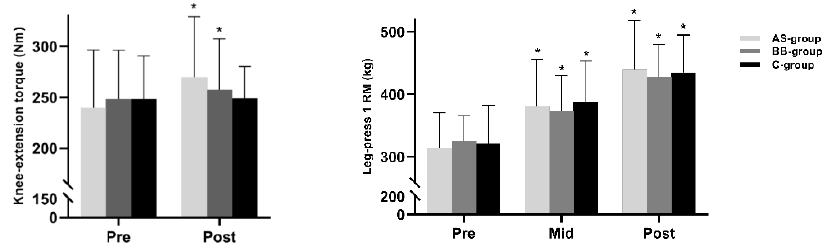
Figure 6. The bar plots of knee-extension (KE) peak torque and leg press 1 RM values in AS, BB, and C group pre, (mid), and post 6-week intervention. Data are presented as mean ± SD. An asterisk (*) indicates the change of relative index is significant ( p <